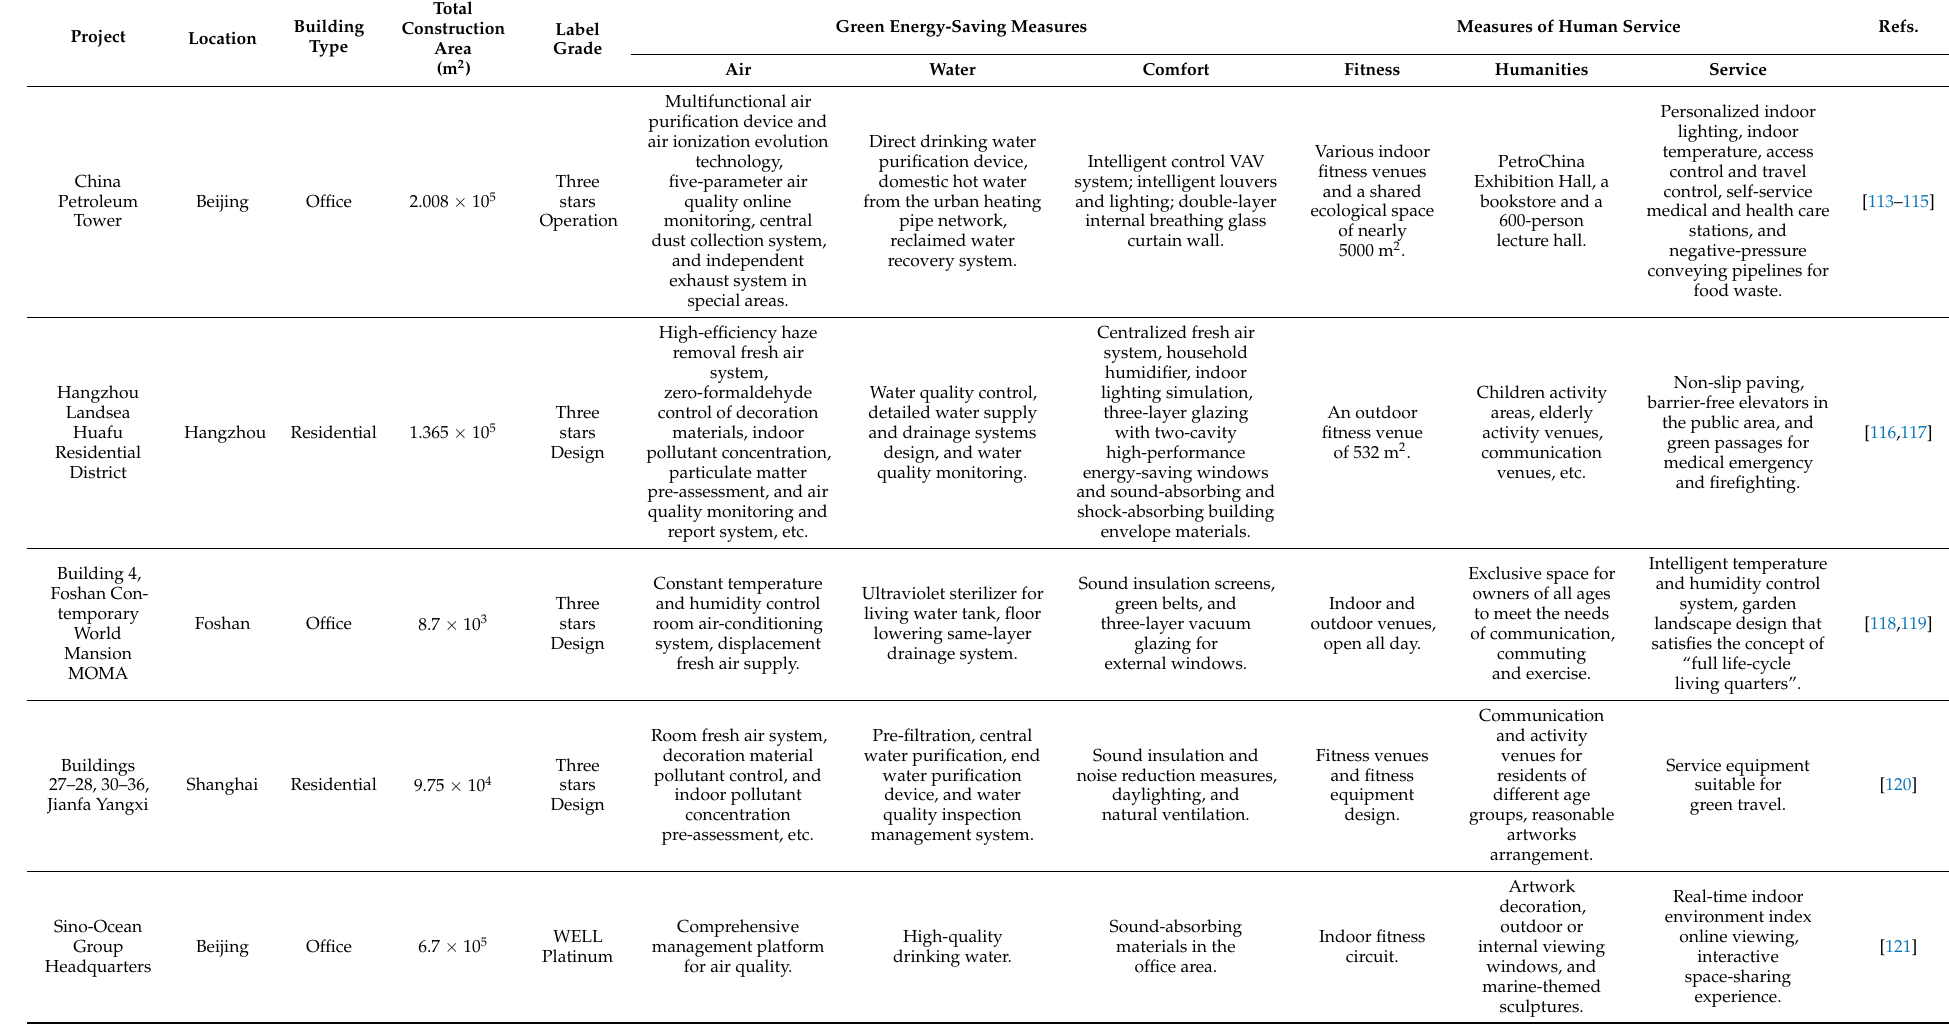
Table 4. Healthy Building Demonstration Projects in